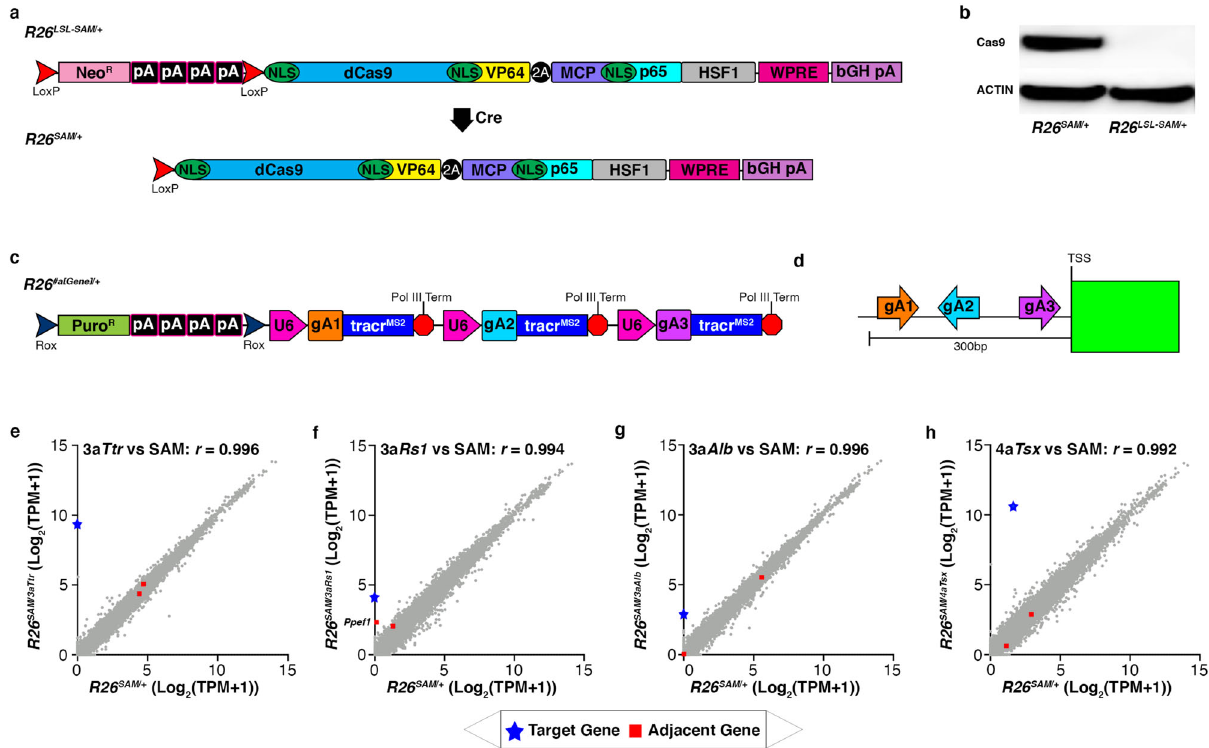
Fig. 1 Characterization and validation of R26 SAM/ + in mESCs. a Schematic of R26 LSL-SAM / + and R26 SAM / + . dCas9 is fused to VP64 with a nuclear localization sequence (NLS). MCP, P65, HSF1 are fused together with an intervening NLS sequence. The hybrid protein sequences are linked via a P2A peptide. Upon treatment with Cre recombinase, the loxP-stop-loxP cassette (LSL) is excised. b A representative western blot showing dCas9 SAM (219 kDA) expression in targeted mESCs. dCas9 SAM signals are normalized to actin (41 kDa). Three independent repeats have been completed with similar results. c Generalized schematic of R26 targeted guide arrays where “ #a ” indicates the number of activating guides included in the array and [ Gene ] refers to the target gene. Each guide is driven by a U6 promoter and separated by an extended RNA Pol III termination sequence. d Illustration of general SAM guide design approach. Guides are selected within 300 bases of the transcriptional start site (TSS) of each gene. e – h RNA-seq characterization of mESC lines harboring targeted gRNA arrays versus the parental R26 SAM/ + line. The transcriptome of each clone was sequenced with fi ve technical replicates to provide the number of target-speci fi c transcripts per million (TPM) sequence reads. The target gene is noted with a blue star and the adjacent genes with red squares. Statistics: Pearson ’ s correlation coef fi cient was utilized to determine the r -value ( e ) r = 0.994, ( f ) r = 0.996, ( g ) r = 0.992, ( h ) r =